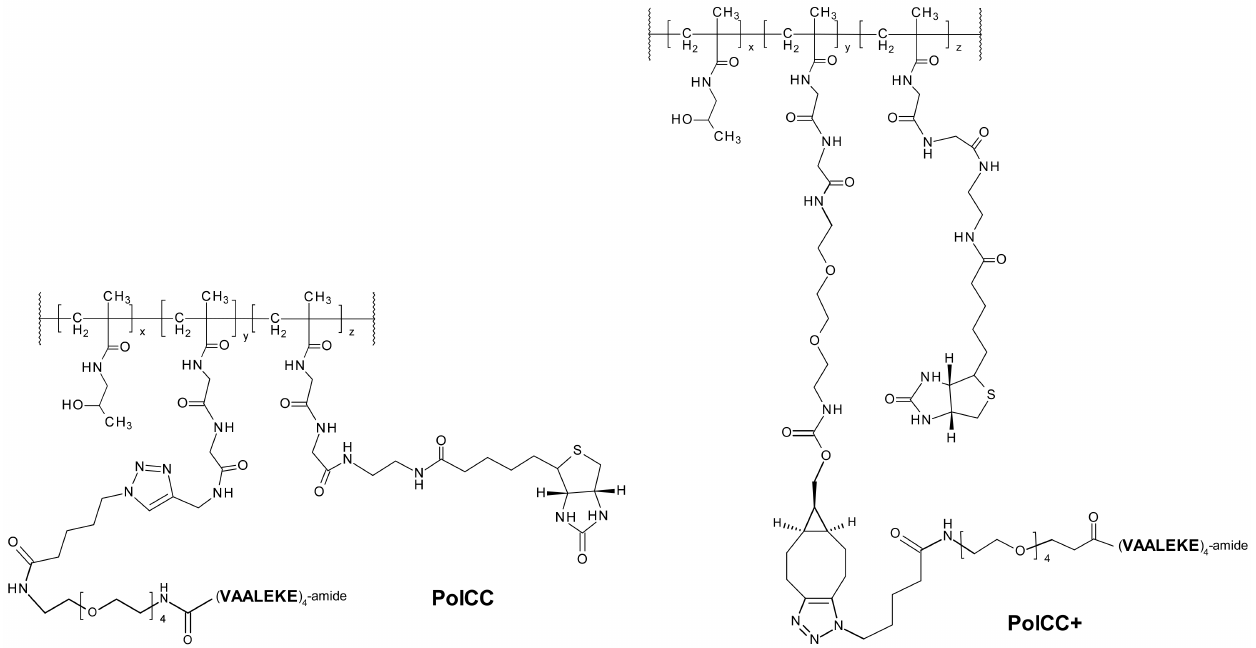
Scheme 1. Representation of PolCC and PolCC+ conjugates’ chemical